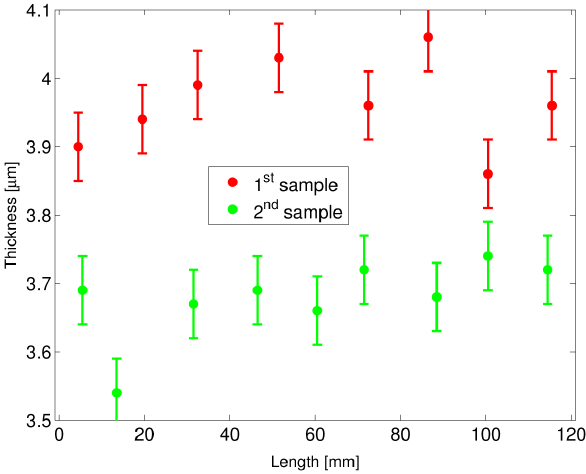
FIG. 4. Measurements of the NEG coating thickness on the two copper slabs used for the